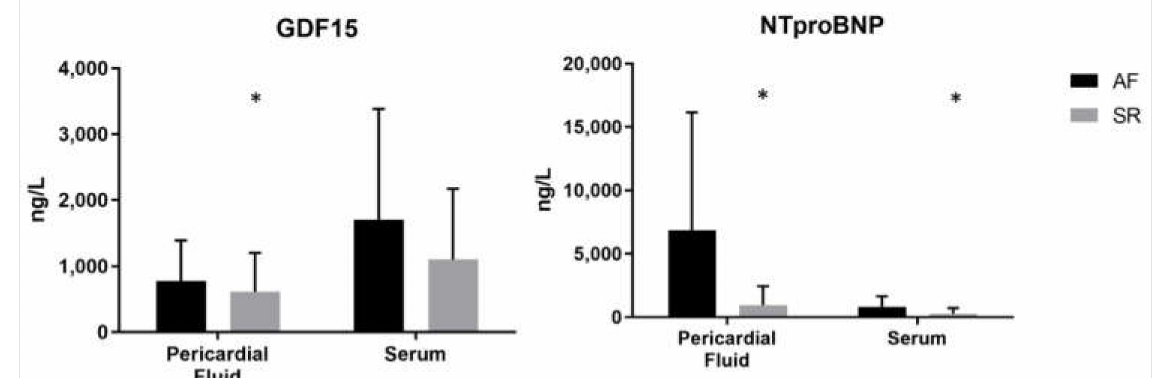
Figure 1. Serum and pericardial fluid GDF-15 and NT-pro-BNP quantifications between atrial fibrillation and sinus rhythm patients. Sample number: pericardial fluid GDF-15 (SR = 48; AF = 17); serum GDF-15 (SR = 86; AF = 9); pericardial fluid NT-pro-BNP (SR = 47; AF = 17); serum NT-pro-BNP (SR = 88; AF = 9). Mann–Whitney U test was used for all comparisons; * p < 0.05.